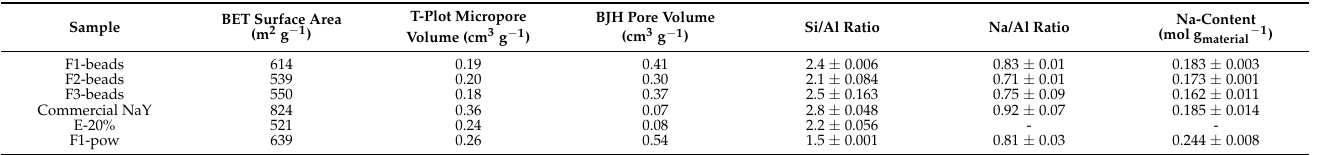
Figure 4. SEM images of: ( A ) commercial NaY powder; ( B ) extrudate from commercial NaY powder (the bottom half was crushed with a spatula to reveal the cross section); ( C ) surface of the extrudate. Table 2. Physicochemical properties of F1-beads–F3-beads, F1 powder side-product (F1-pow), com- mercial zeolite Y (NaY), and extrudates prepared from commercial zeolite Y